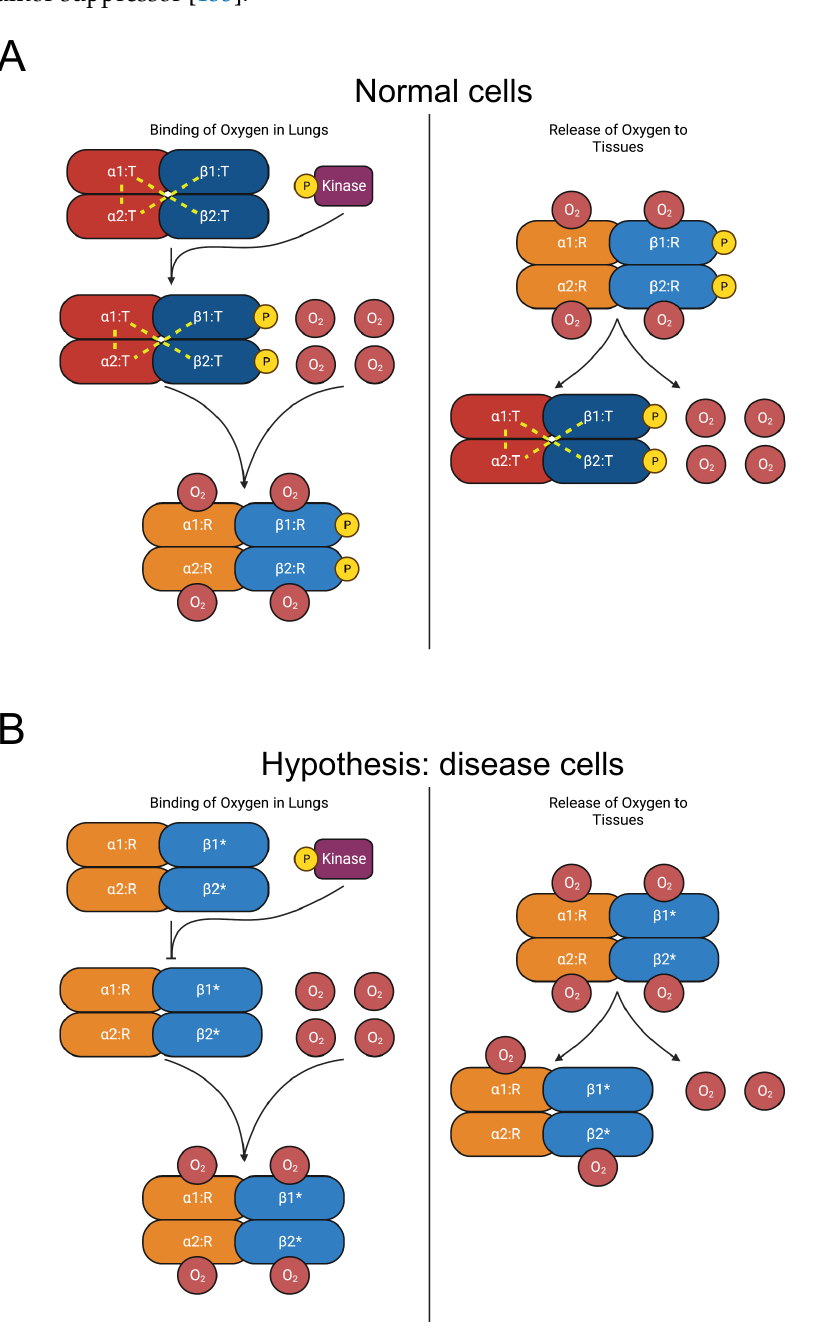
(Figure 7A) [133]. In addition to its role in cell metabolism, the SDH complex operates as a tumor suppressor [135].